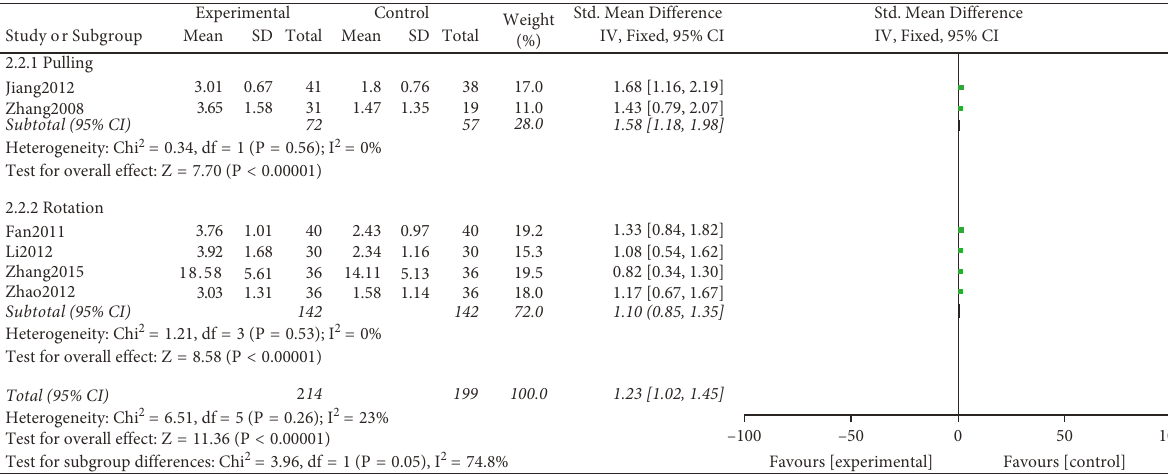
Figure 6: Comparison between the mean difference scores before and after treatment of VAS scores of manipulation and cervical traction in the treatment of CSR.